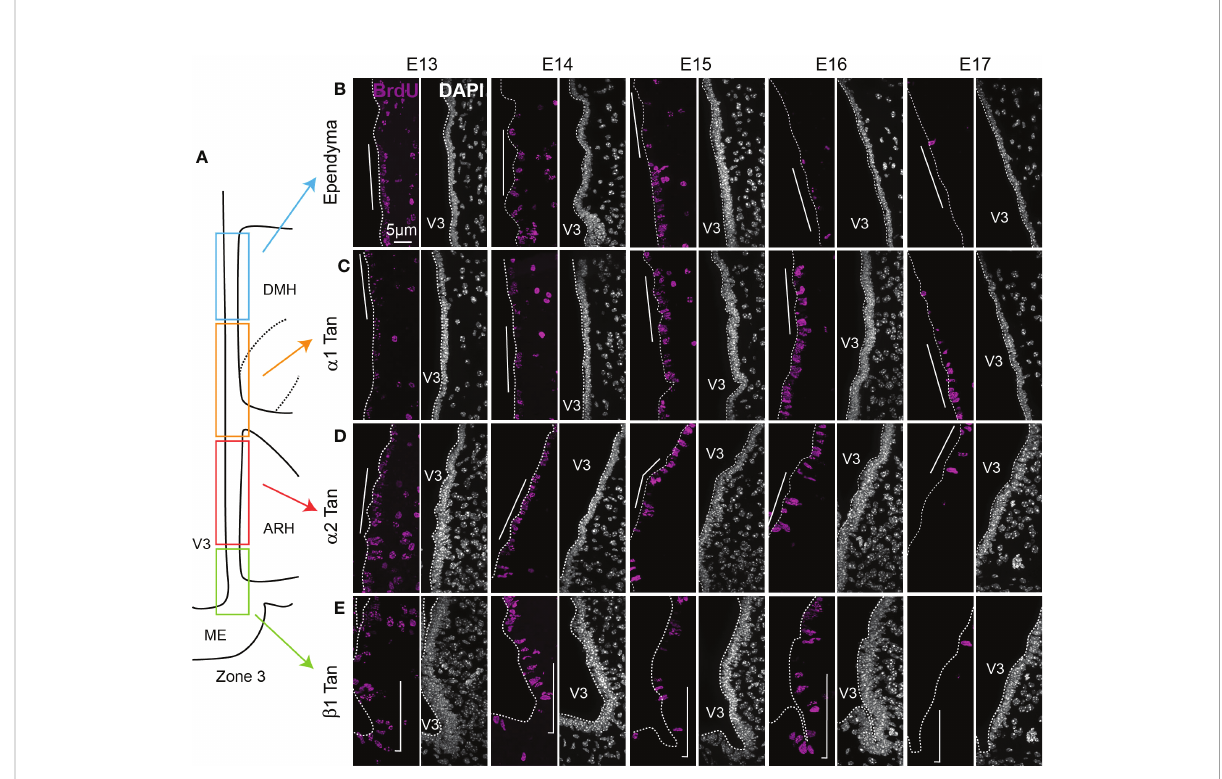
FIGURE 5 Characterization of BrdU-positive ependymoglial cells along the ventricular wall. (A) Schematic representation of zone 3 in the mediobasal hypothalamus. Rectangles display the different ependymal regions used for the analysis: beta-1 tanycytes facing the lateral ME and the vmARH ( b 1 Tan), alpha-2 tanycytes facing the dmARH ( a 2 Tan), alpha-1 tanycytes facing the cDMH ( a 1 Tan), and typical ependymal cells facing the dorsal part of the DMH. (B – E) High-magni fi cation z-stack (63x) illustrative coronal images showing the distribution of BrdU immunoreactivity (pink) in the typical ependymal cells (B) , a 1 (C) , a 2 (D) , and b 1 (E) from the developmental timepoint E13 to E17. DAPI counterstaining is represented in white. The white bars point out the respective cells of interest along the third ventricle. ARH, arcuate nucleus of the hypothalamus; DMH, dorsomedial nucleus of the hypothalamus; ME, median eminence; V3, third ventricle. The scale bar is shown in the fi gure. See File